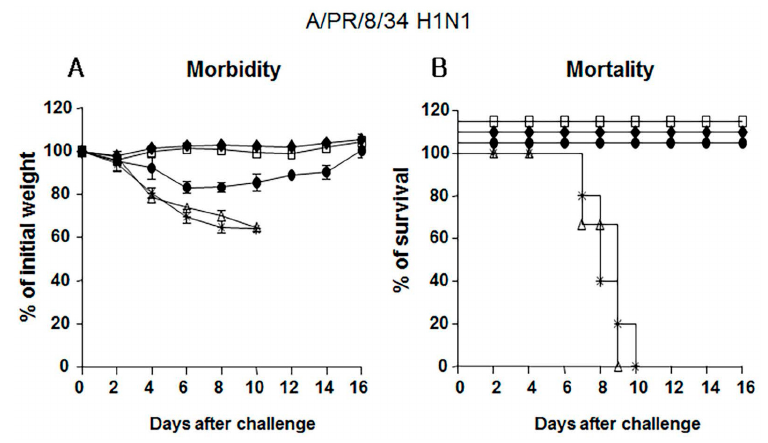
Figure 4. Passive immunization of immune sera from rAdH5/M2e vaccinated mice provided protection against influenza virus challenge infection. Anesthetized Balb/c mice were passively immunized by intranasal administration of sera from mice immunized with FiPR8+CT, live PR8 virus, or rAdH5/M2e vaccine. Control mice received sera from unvaccinated mice or phosphate buffered saline (PBS) only. Six hours later, recipient mice were infected with 5LD 50 of mouse-adapted A/PR/8/34 (PR8) (H1N1) virus ( A , B ) or A/Aquatic bird/Korea/W81/2005 (H5N2) virus ( C , D ). Morbidity and mortality were monitored daily for two weeks after challenge infection. Body weights are expressed as the mean of the percent of starting body weight ± SD. Mortality is expressed as Kaplan-Meier survival curves. Each experimental group consisted of 5 mice per group. The data represent results from three independent experiments of five mice per group. The differences in body weight on days 5 and 6 between the groups immunized with live PR8 or vectored vaccine and formaldehyde-inactivated or unimmunized are statistically significant ( p <